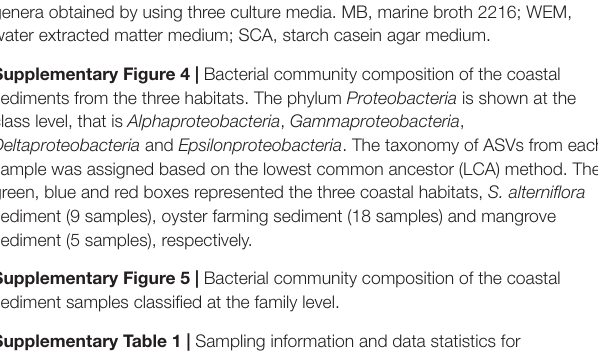
Supplementary Table 5 | Taxonomy and sequence similarity of the isolates representing novel